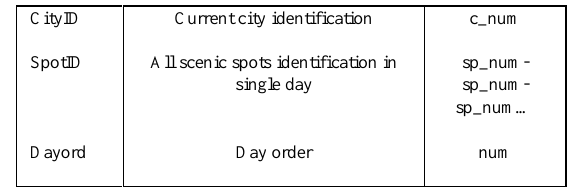
Table 2. Single day route data